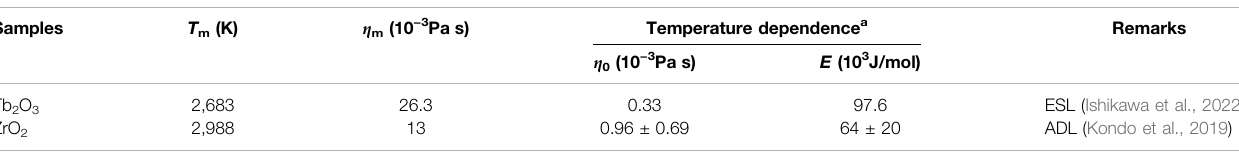
TABLE 6 | Viscosity of molten Ln 2 O 3 and ZrO 2 . Samples Temperature dependence